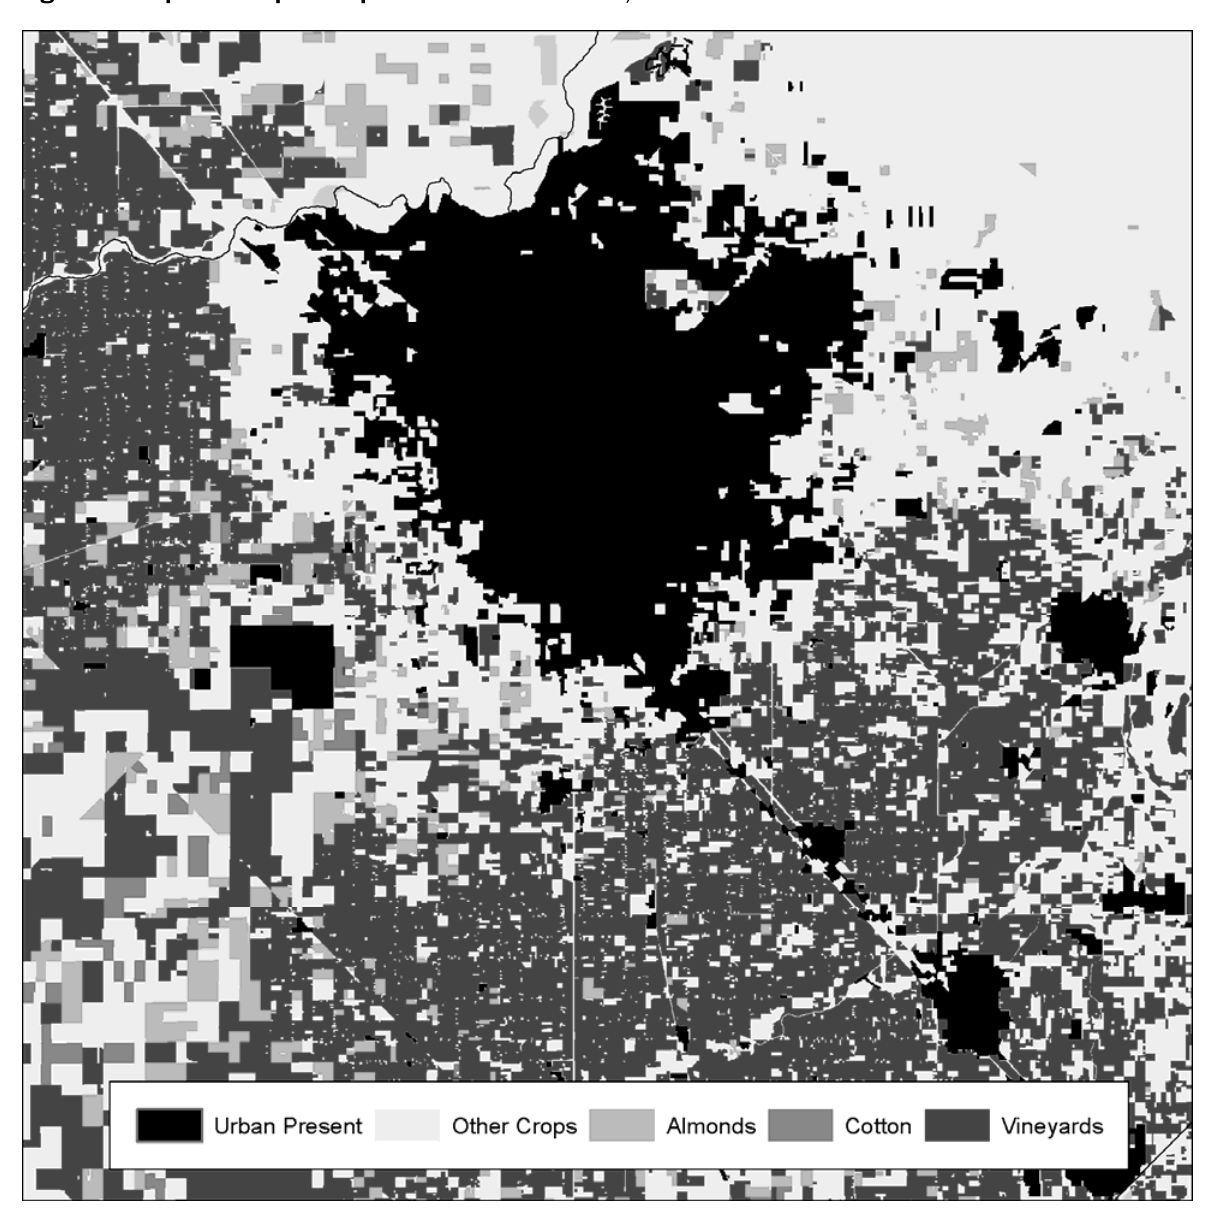
Figure 1. Simplified Map of Crop Locations Near Fresno,